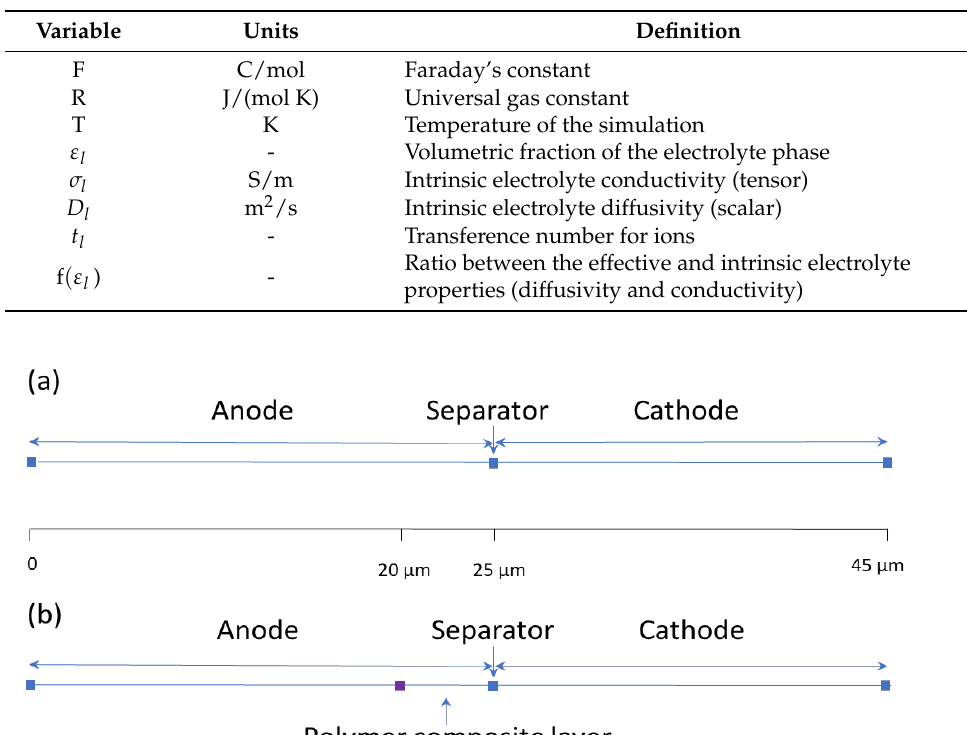
Table 2. List of inputs that are required by COMSOL for simulating the ion transport across the LISB.